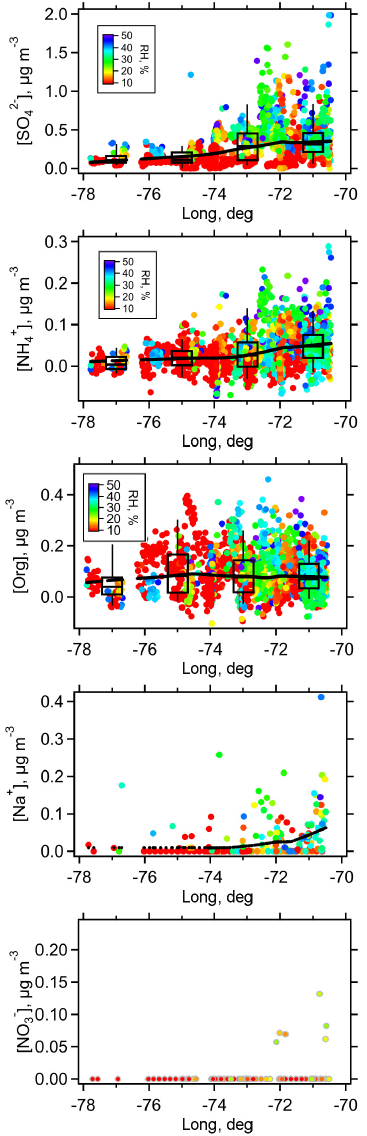
Figure 5. Composite longitudinal distributions of aerosol concen- trations of AC SO 2 − , NH + , Org, Na + , and NO − measured on the 4 4 3 G-1 for the entire mission. Data are color coded to RH; solid black line represents LOWESS smooth. Box plots are for two-degree binned